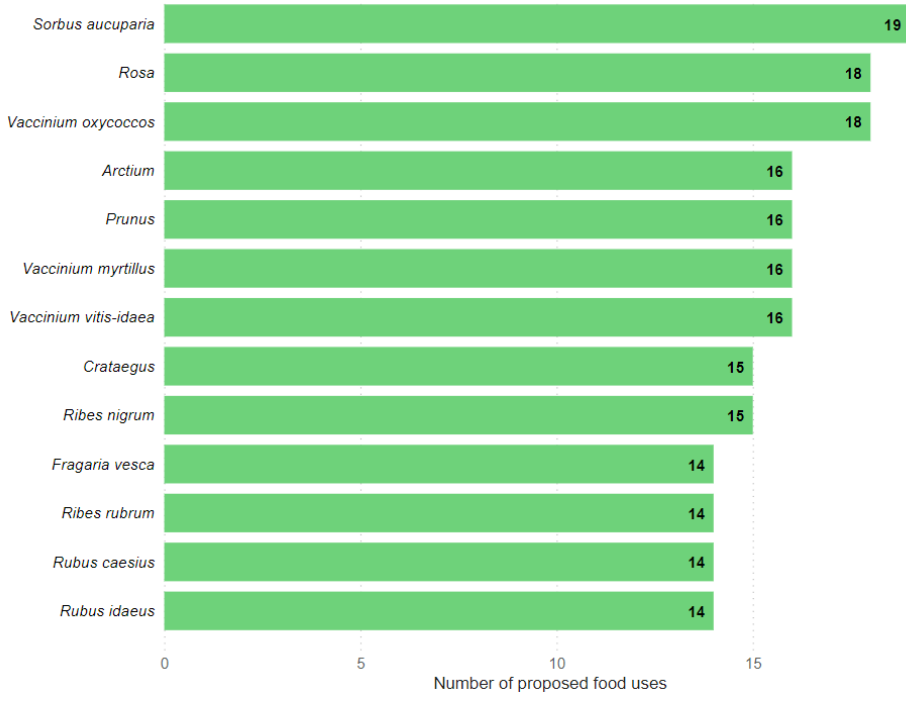
Figure 2. The top 13 plant taxa according to the number of proposed modes of food use in the aforementioned